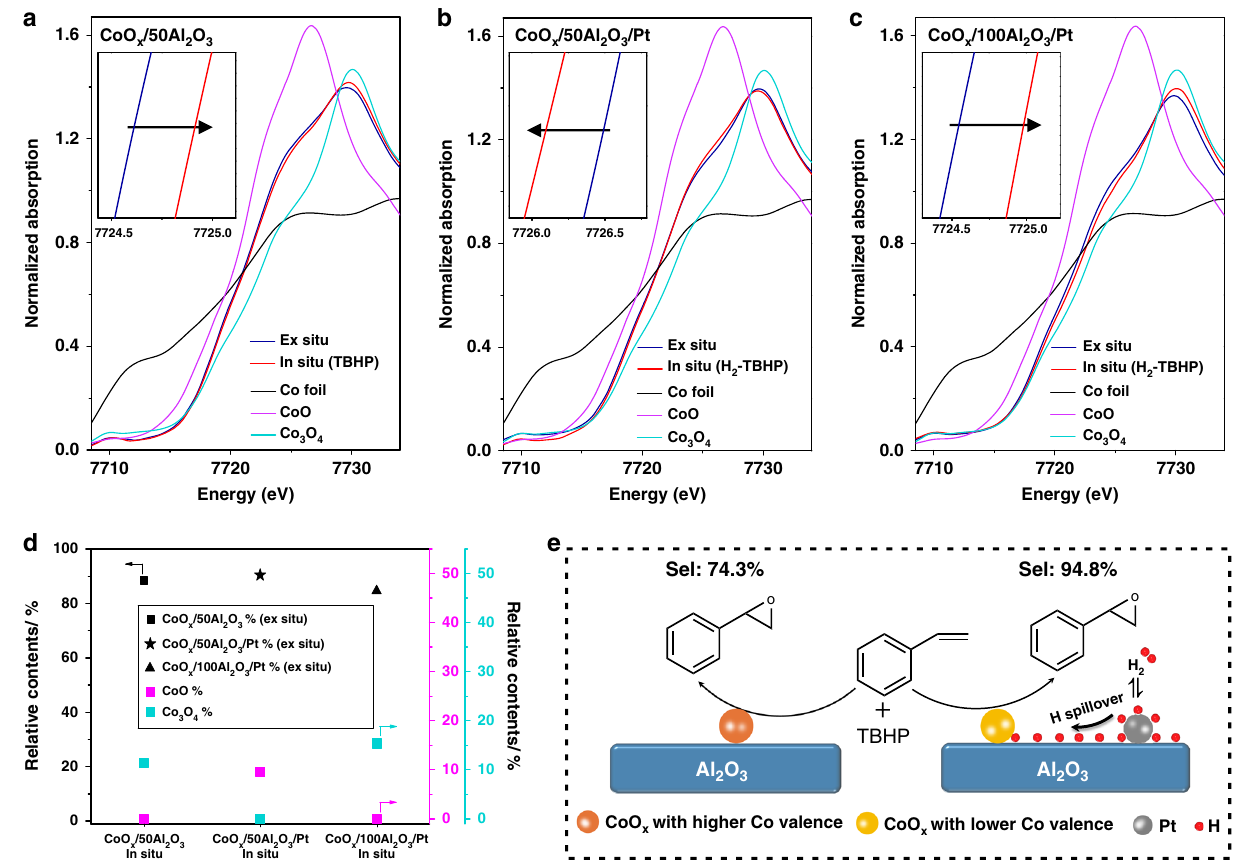
Fig. 6 XANES spectra of the catalysts and proposed mechanisms. a – c Ex situ and in situ Co K-edge XANES spectra of CoO x /50Al 2 O 3 , CoO x /50Al 2 O 3 /Pt, and CoO x /100Al 2 O 3 /Pt, and spectra of reference samples (Co foil, CoO, and Co 3 O 4 ). Insets show the expanded sections of absorption edges. d The results of the linear combination fi tting for the in situ spectra of the catalysts. For each catalyst, the in-situ spectrum is fi tted by a linear combination of the ex-situ spectrum and the spectra of reference samples (Co 3 O 4 and CoO). e Proposed reaction mechanisms for CoO x /50Al 2 O 3 in the TBHP condition and CoO x /50Al 2 O 3 /Pt in the H 2 -TBHP condition. In the presence of controllable hydrogen spillover, cobalt species with a lower valence state are bene fi cial to the enhanced (Fig. 6a – c). The ex situ X-ray absorption near-edge structure